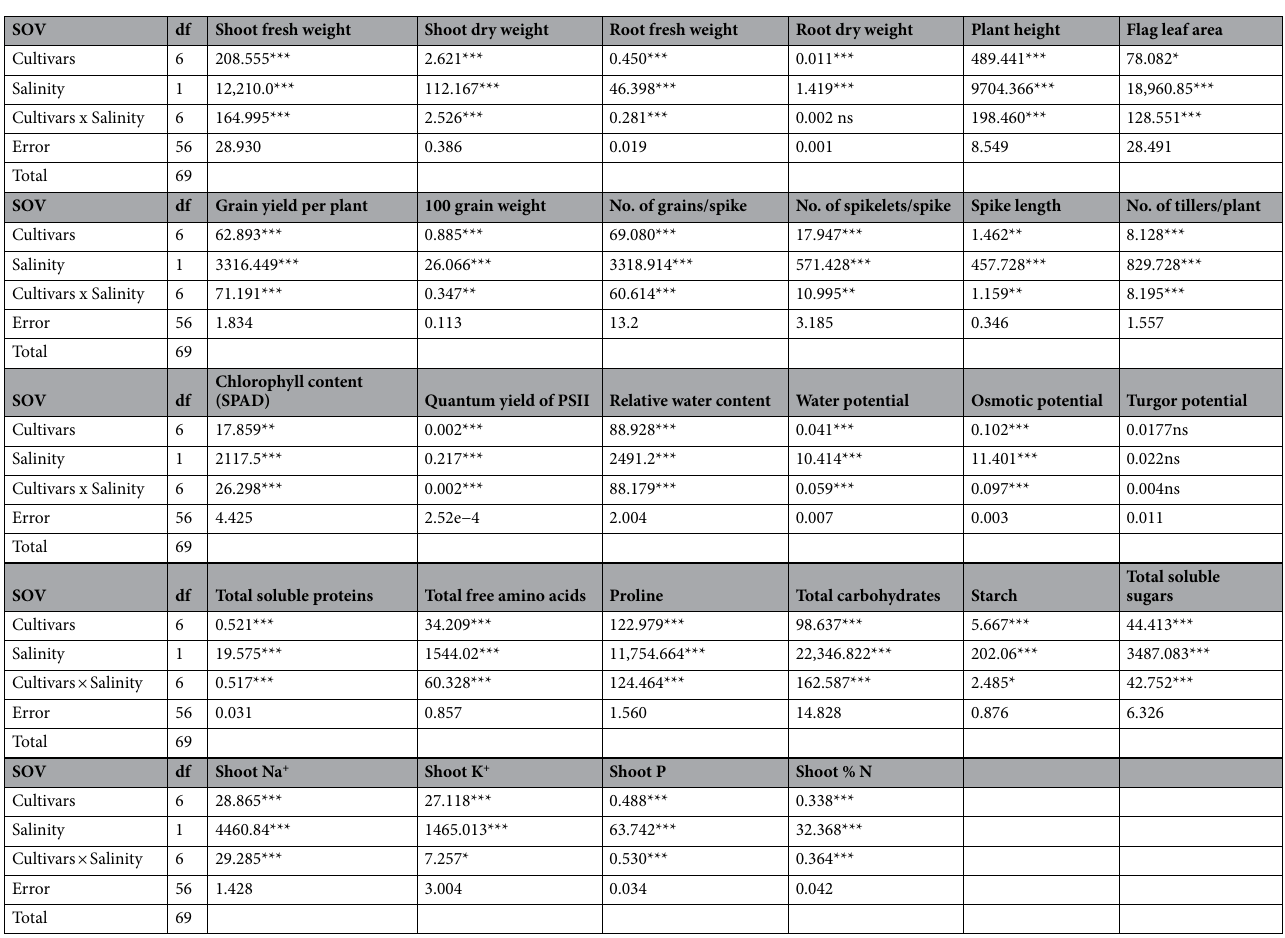
Table 1. Mean squares from ANOVA of the data for growth attributes, yield parameters, photosynthetic pigment and quantum yield of PSII, water relation parameters, total soluble proteins and free amino acids, proline, total carbohydrates, starch, soluble sugars and inorganic solutes of seven local wheat cultivars when subjected to 150 mM NaCl salinity. ns non-significant, SOV source of variation, df degree of freedom. * , ** , ***significant at 0.05, 0.01, and 0.001